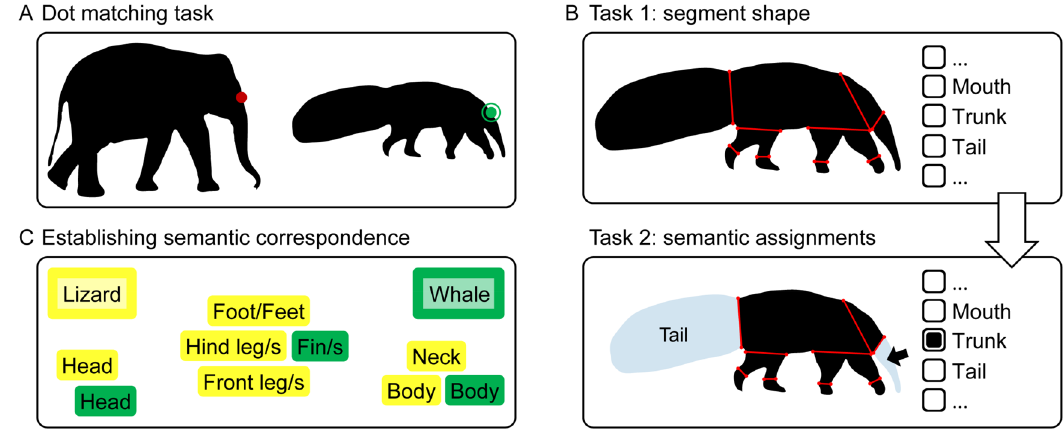
Figure 3. Overview of experimental paradigms. ( A ) Example response in the dot-matching task (Experiments 1 and 2), where participants see a probe point (red) on the contour of the base shape (e.g., elephant) and are instructed to place a bullseye (green) on the corresponding location on the contour of the test shape (e.g., anteater). ( B ) Example response for identifying and labeling parts (Experiment 3A). For each shape, participants first identify part cuts by using the computer’s mouse to choose two locations on the contour (Task 1). After they identified as many parts as they like to, they assign labels to these parts by selecting them and choosing a label from a list (Task 2). ( C ) Example response for establishing correspondence between semantic part labels (Experiment 3B). Participants sorted together color-coded names of animal parts identified in